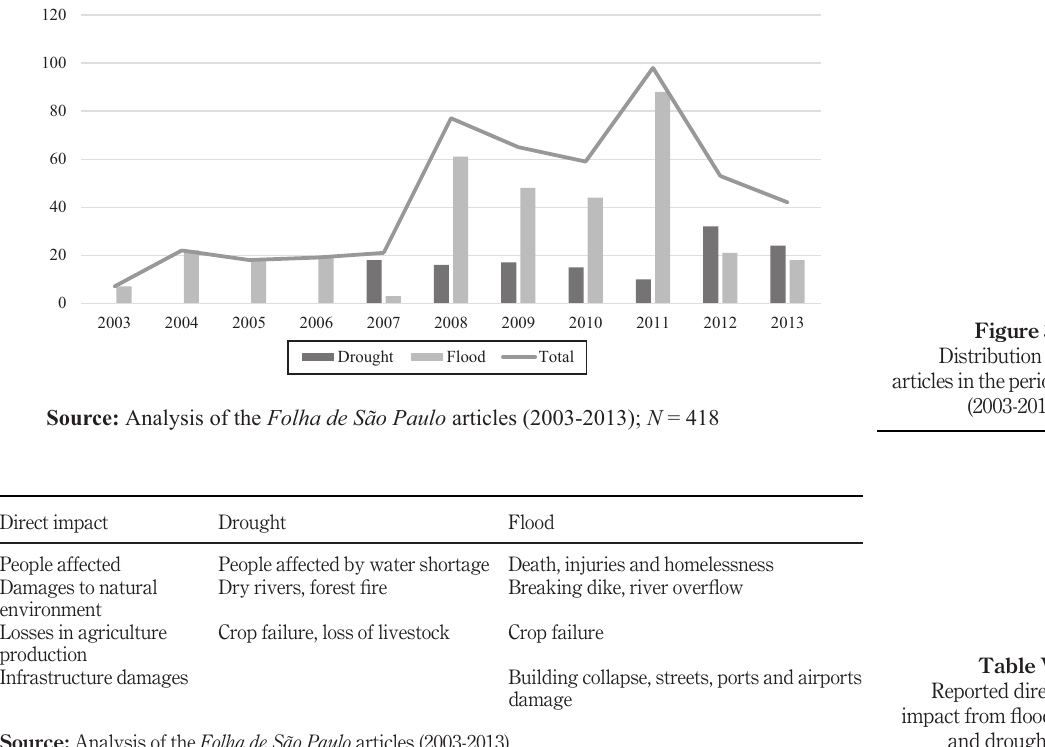
Table V. Reported